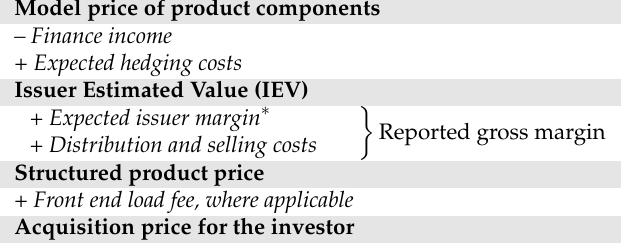
Figure 1. Price Components of a Retail Structured Product. This figure shows structured product price components according to Reference [18]. The asterisk (*) indicates that beyond the issuer’s expected profits, the expected issuer margin covers operational costs incurred by product structuring, admission, market making and